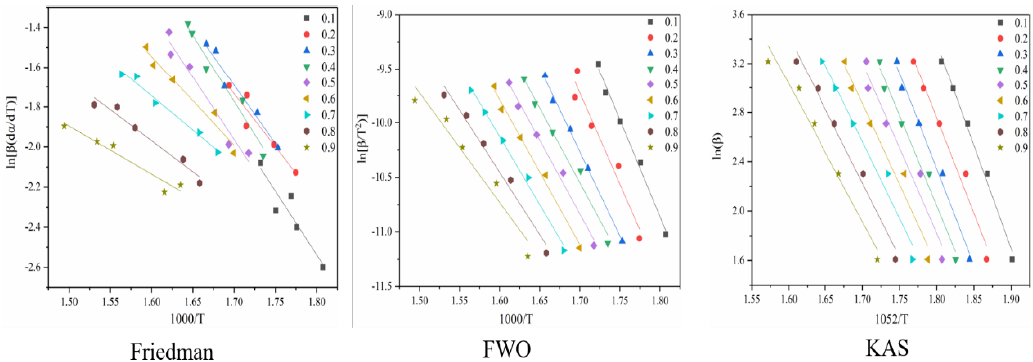
Figure 6. Conversion curve of the second stage of battery material pyrolysis.